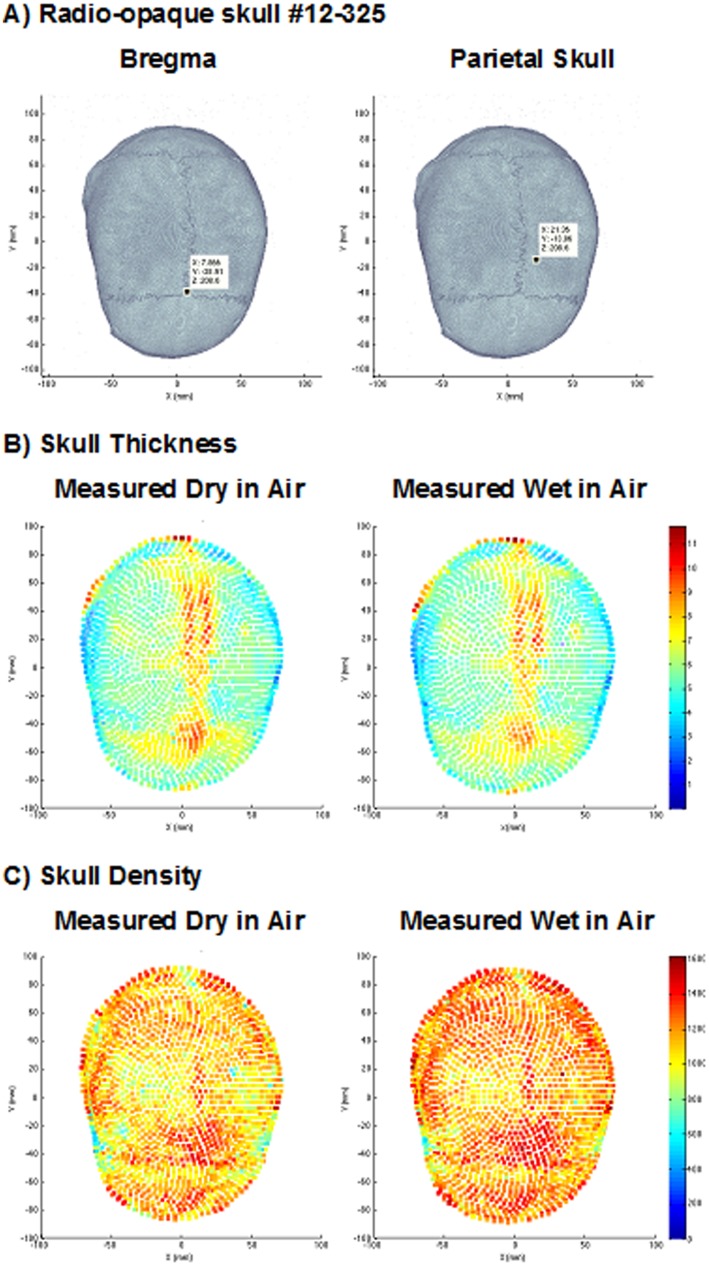
CT Scan Analysis of Calvaria #12–325.(A) Radio-opaque skull- Human Calvaria Measurement Point coordinates; (B) Skull Thickness Profiles and (C) Skull Density Profiles. Parametric maps of overall skull thickness and density. Vector positions for measurements are shown in A, Thickness (B) and density (C). Left panels dehydrated calvaria measurement in air; Right panels hydrated degassed measured in air.